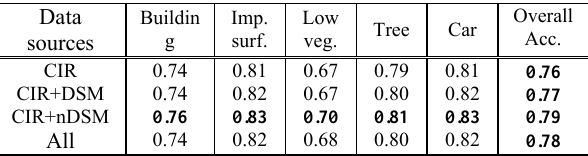
Table 2. Performance comparison (F1-scores for respective class) of the CNN with different input data sources Multi-resolution CNN feature